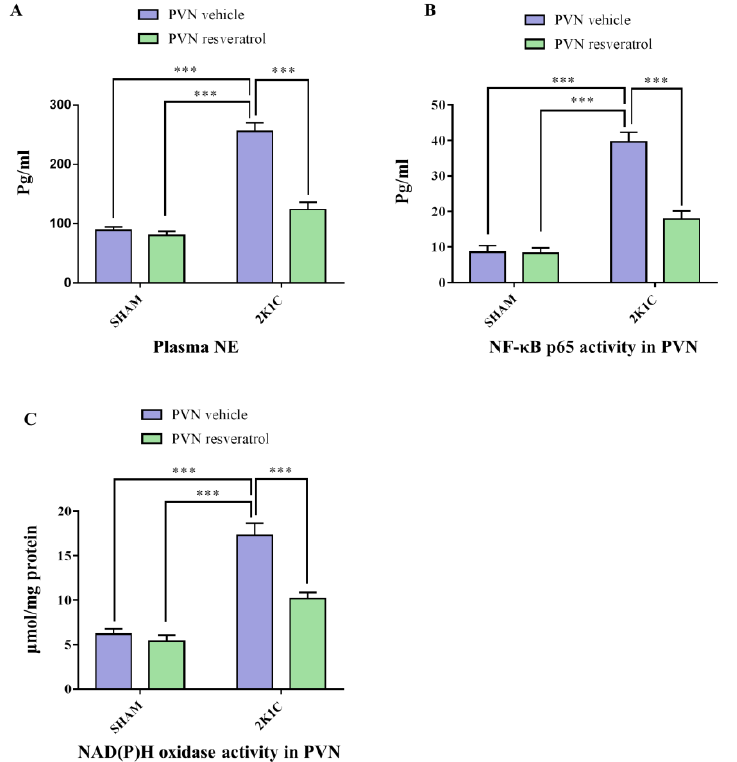
Figure 2. The effects of resveratrol on the plasma levels of NE, and PVN levels of NOX and NF- κ B activation. ( A ) Statistical analysis of NE; ( B ) Statistical analysis of NF- κ B p65 activity; and ( C ) Statistical analysis of NOX. Values are the mean ± SEM. *** p < 0.001, n = 4 – 5.